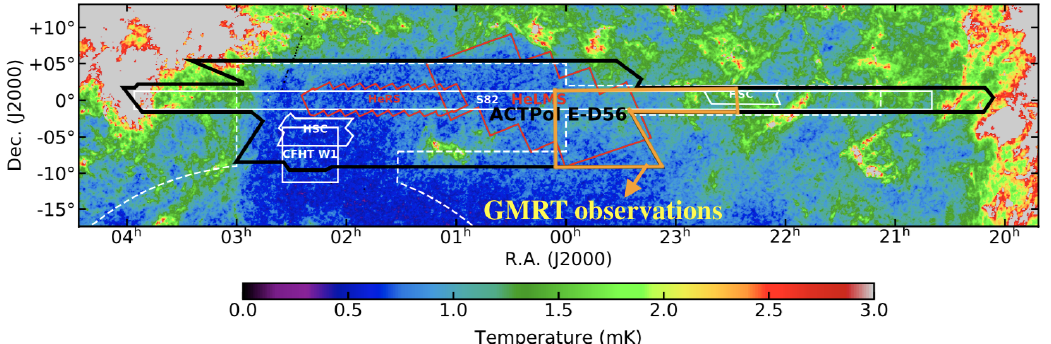
Figure 1. The Planck 353 GHz temperature map overlaid with the ACTPol E − D56 region (shown in black) and the overlapping multi-wavelength surveys. The region enclosed by the magenta polygon indicates the region of the selected final sample, which we follow up using u/GMRT observations. Source: Adapted from Hilton et al.